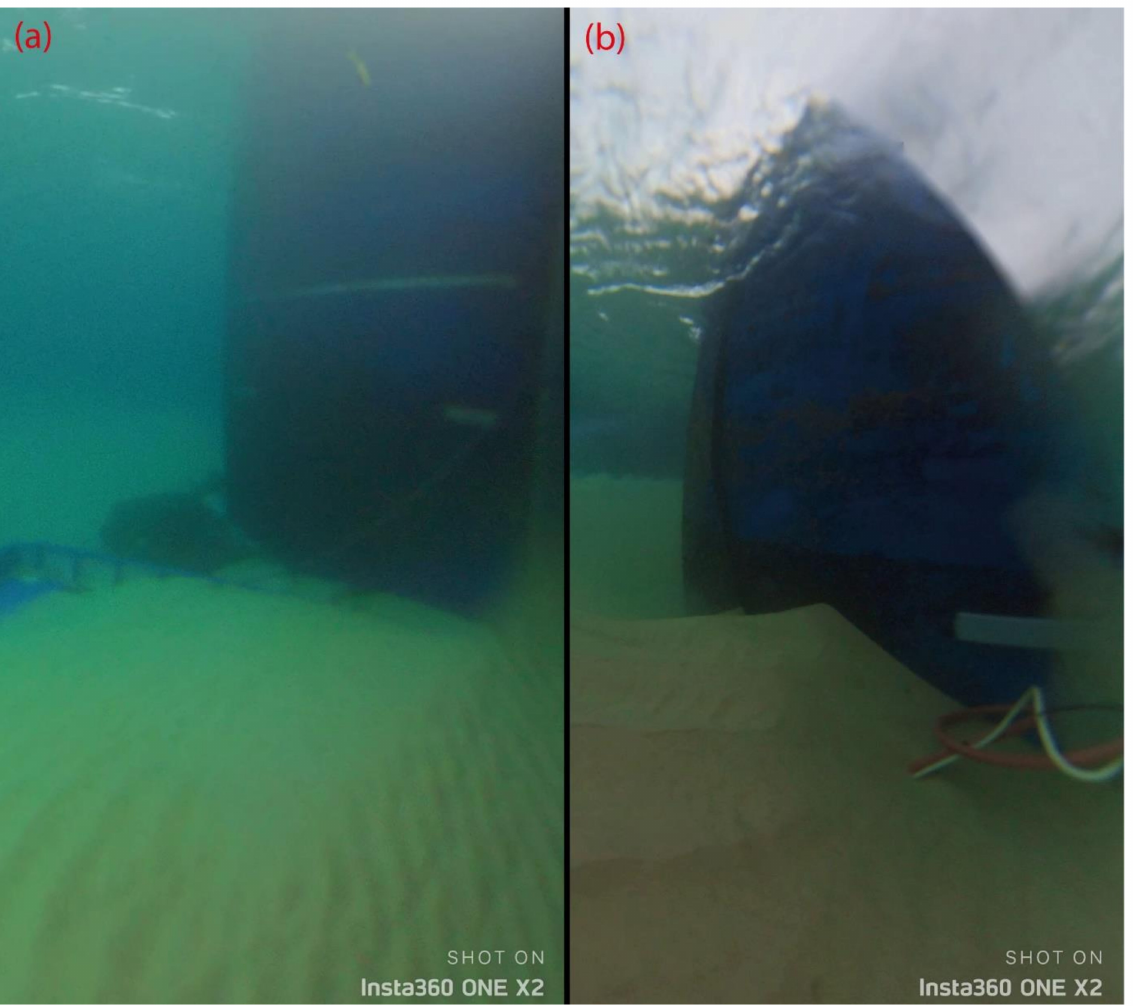
Figure 11. Under-water photographs taken around the OWC WEC at Location 2 on 16 June 2021. ( a ) Photograph taken from in front of the chamber opening, above the opened door, facing towards the Southern corner of the Western pontoon. Sediment has infilled above the door and the Western pontoon is now embedded in sediment. ( b ) Photograph taken of the Northern corner of the Western pontoon. A scour hole is visible at the corner on the outer edge of the pontoon, but the pontoon remains embedded in